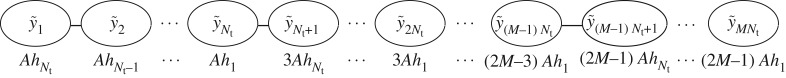
Received symbols constellation in the absence of noise. A is I/M.